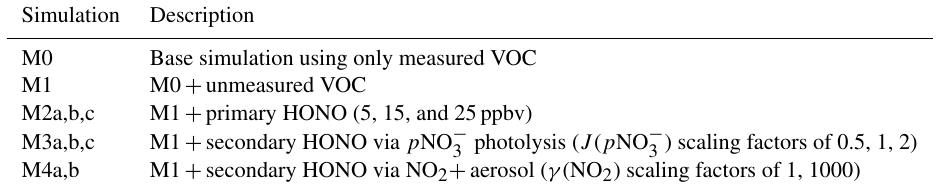
Table 1. Summary of model simulations. Note: ppbv is parts per billion by